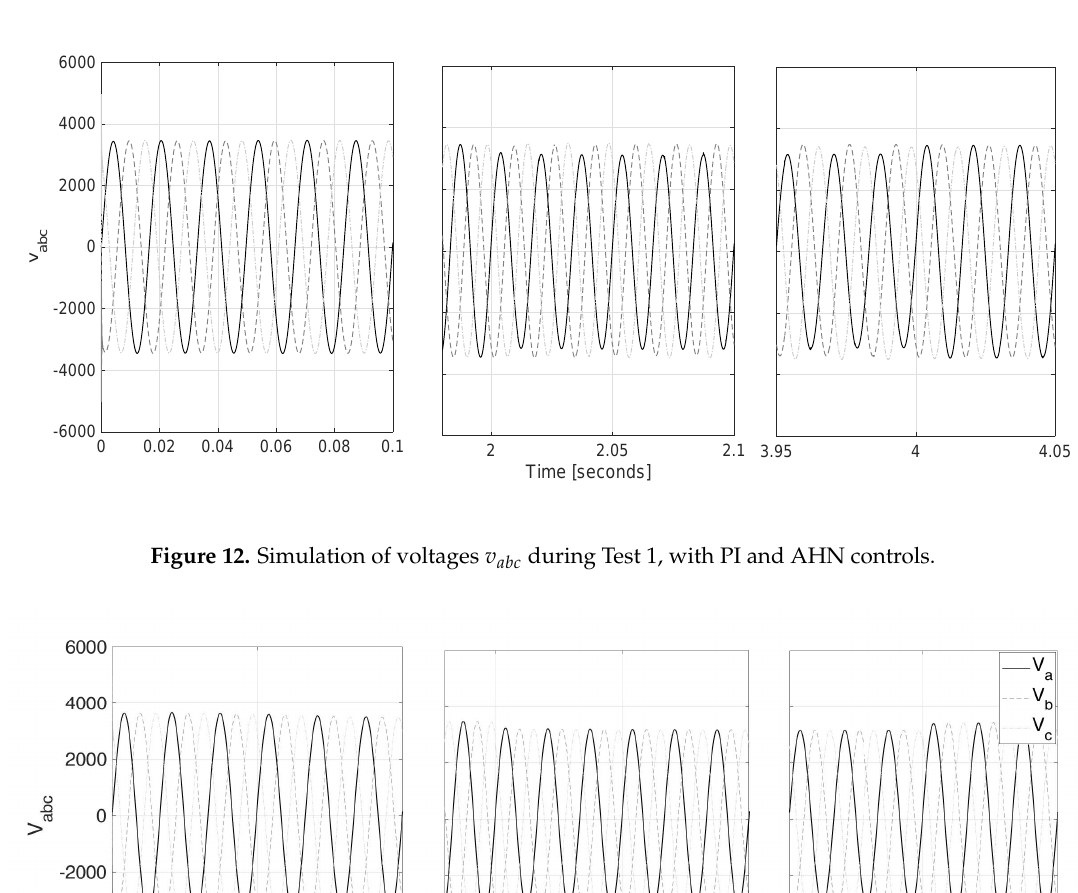
Figure 11. Simulation of voltages v abc during Test 1, with PI control.